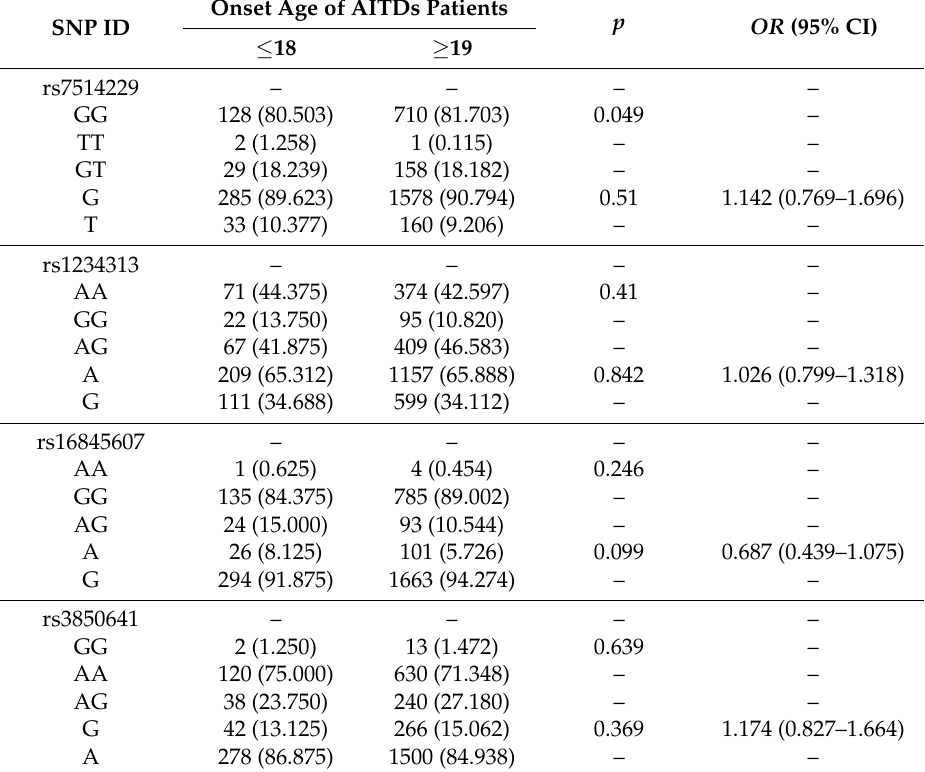
Table 5. Allele and genotype distribution of TNFSF4 in AITDs patients with or without early-onset